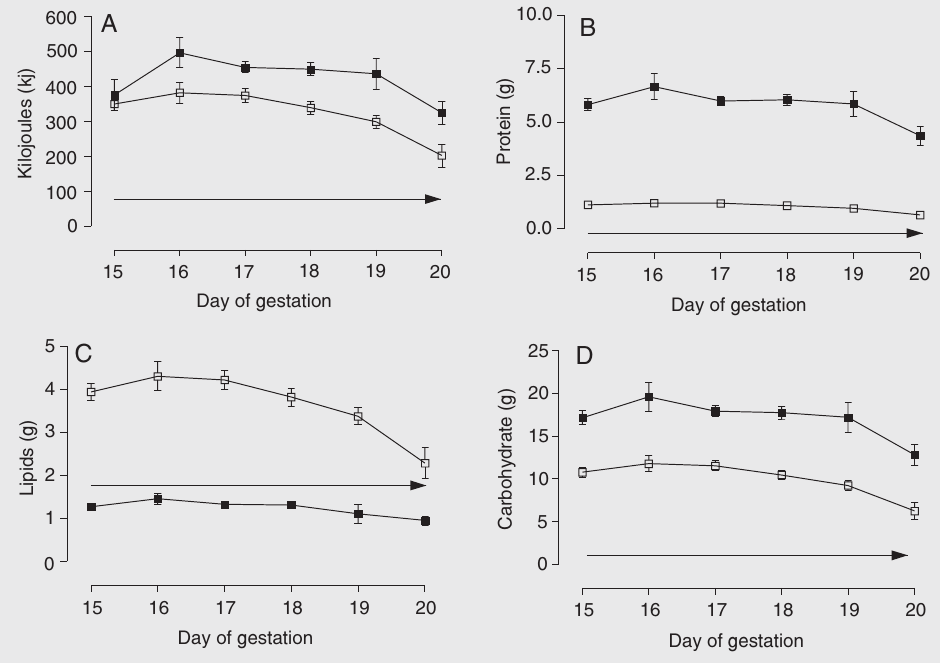
Figure 3. Energy (A), protein (B), lipid (C), and carbohydrate (D) intake of control dams (filled squares) and dams receiving a high-fat and low-protein diet (open squares), during lactation. The comparison was made for each day and the arrow indi- cates that the significance oc- curred during all the period. Data are reported as means ± SEM for 8 animals per group. A , F = 952.5 for diet and 36.7 for